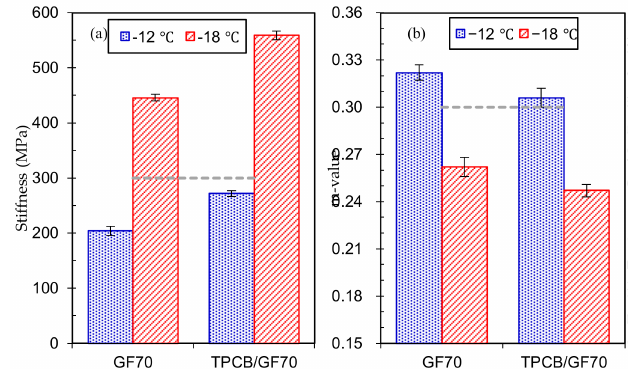
Figure 7. Stiffness ( a ) and m-value ( b ) of GF-70 and TPCB/GF-70.